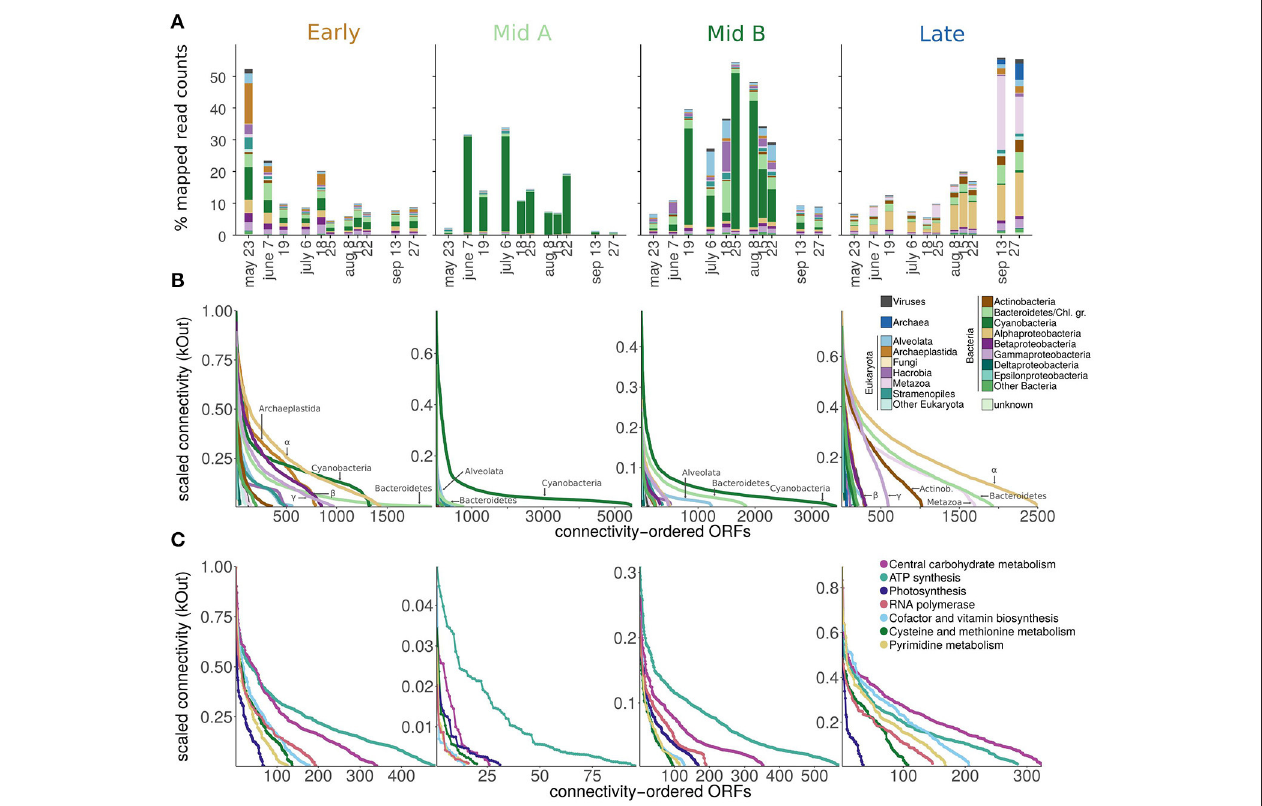
FIGURE 4 | Expression and connectivity within the four components of the time-series, which are characterized by genes having their expression peaks during early, intermediate and late periods of the bloom (termed “Early,” “Mid A,” “Mid B,” and “Late” components). (A) Taxonomic composition of gene expression. (B) Inter-module network connectivity of individual ORFs (ordered by connectivity) divided after taxonomic group and (C) function. For legibility, only the seven most abundant functions are plotted